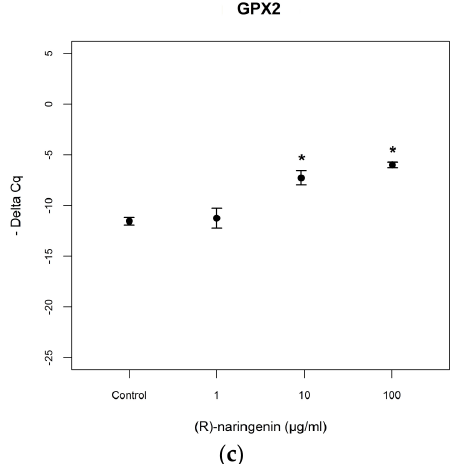
Figure 4. Expression levels, reported as Delta Cq, of mRNA coding for GPx2 in Caco ‐ 2 cells treated with increasing concentrations of ( a ) racemic naringin, ( b ) ( S ), and ( c ) ( R ) naringenin enantiomers (1–100 μ g/mL). * Indicates statistically significant differences between treated and untreated cell cultures, as reported in the text.